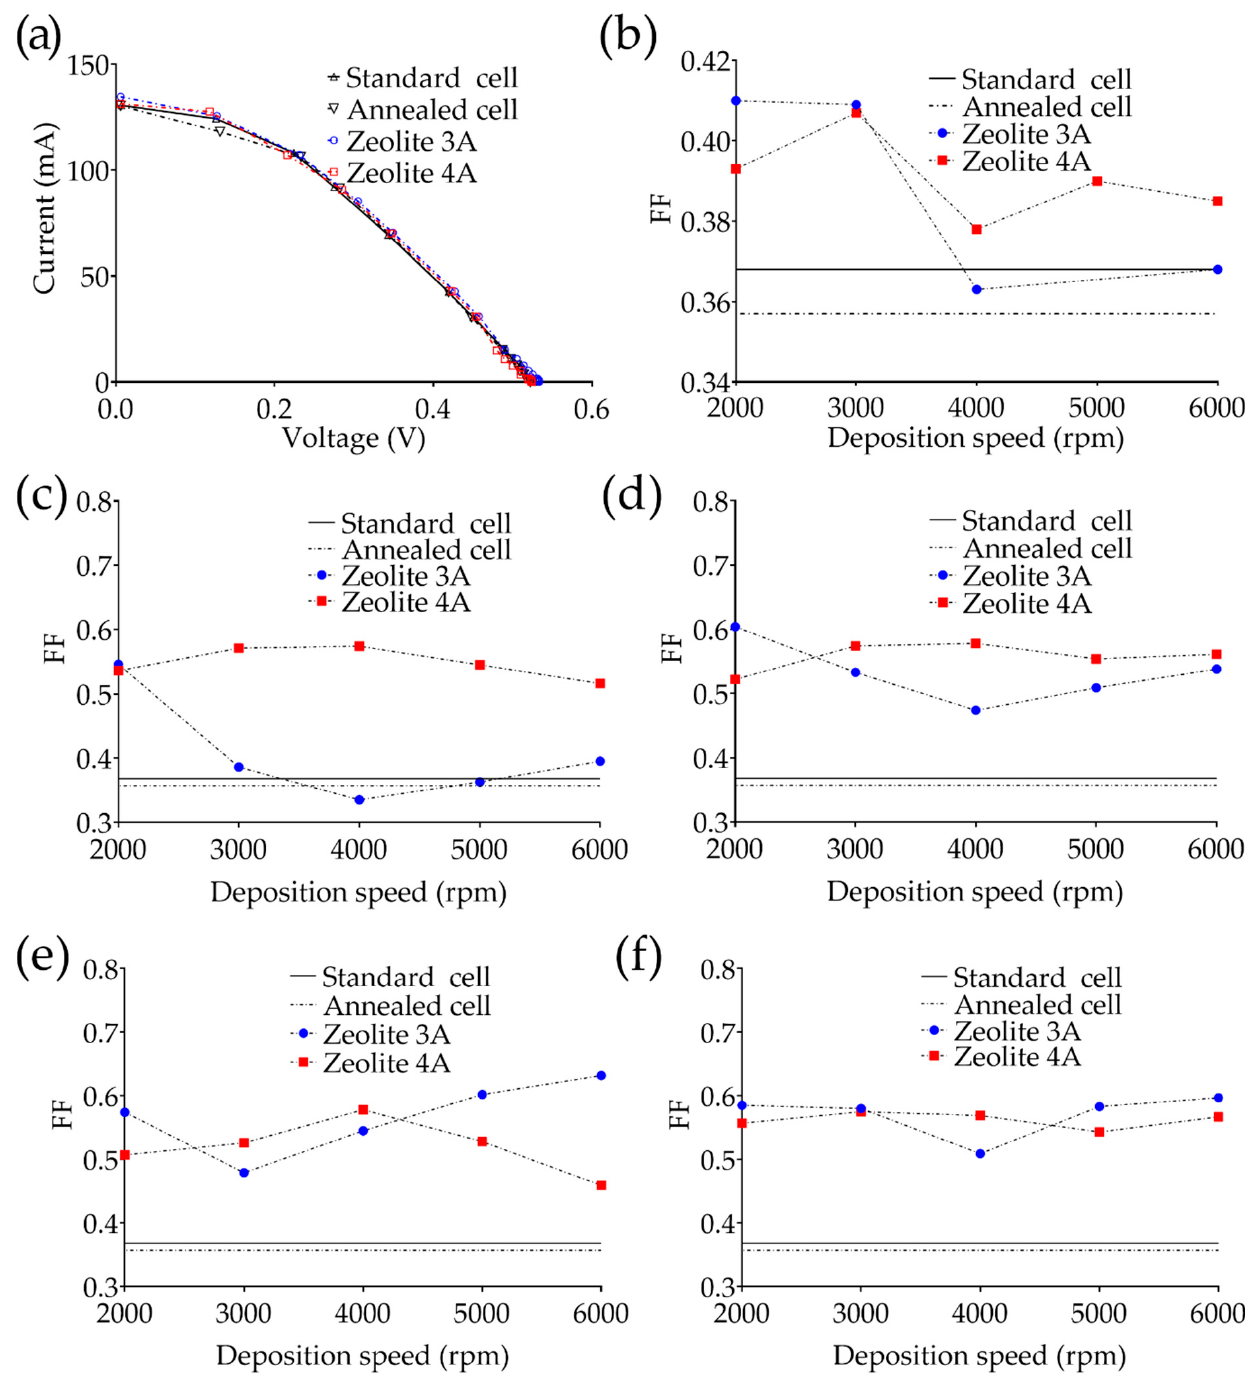
Figure 3. ( a ) I-V characteristics of: standard, annealed solar cell and two representative cells coated with zeolite type 3A and 4A. Fill factor vs. deposition rate in the range 2000–6000 rpm using ( b ) unpolarized white light, ( c ) blue light at 470 nm, ( d ) green light at 530 nm, ( e ) yellow light at 590 nm and ( f ) red light at 610 nm.